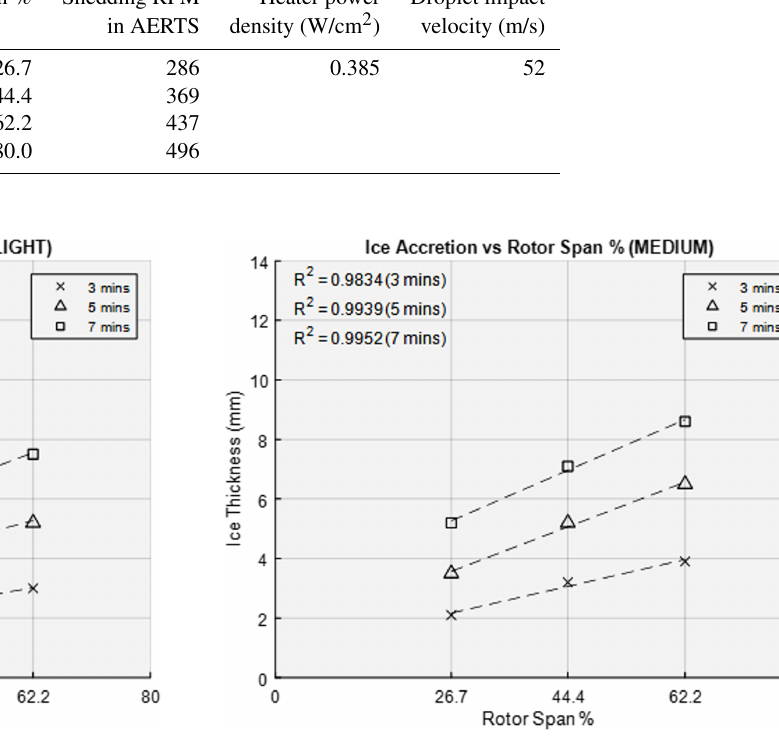
Figure 12. Ice thickness measurements for light icing conditions. Figure 13. Ice thickness measurements for medium icing condi-